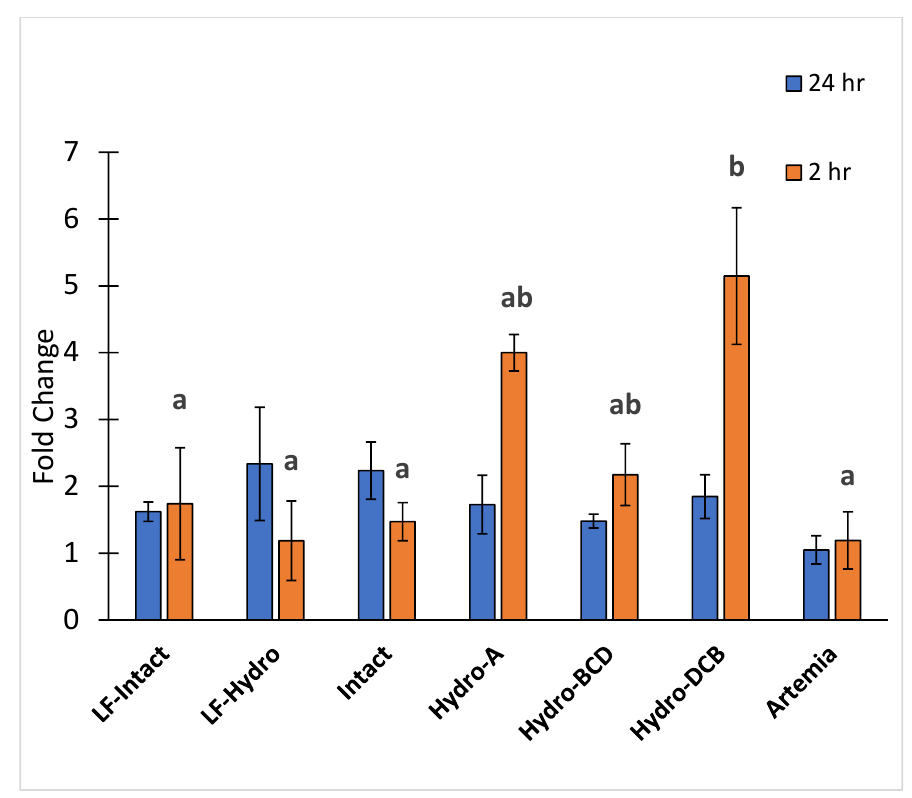
Figure 7. Relative expression of peptide transporter PepT1. Letters indicate statistical significance between groups. The significance was determined using a One-way ANOVA and an LSD test with a p value < 0.05 .